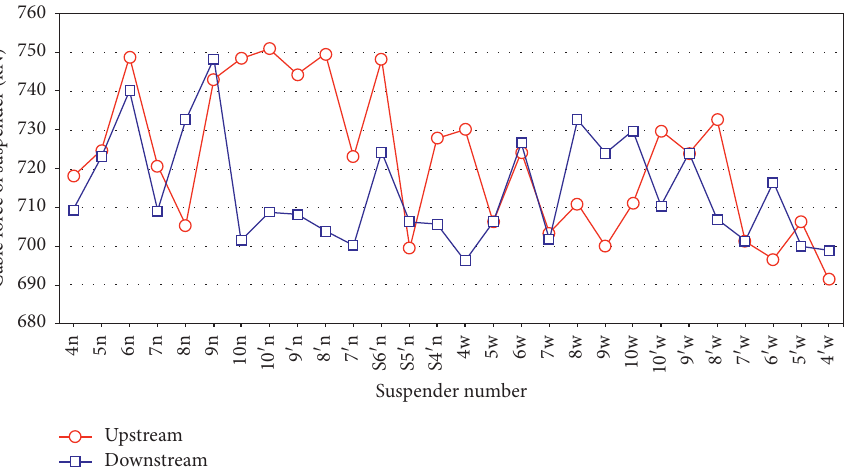
Figure 24: Cable force of upstream long suspender after correction.